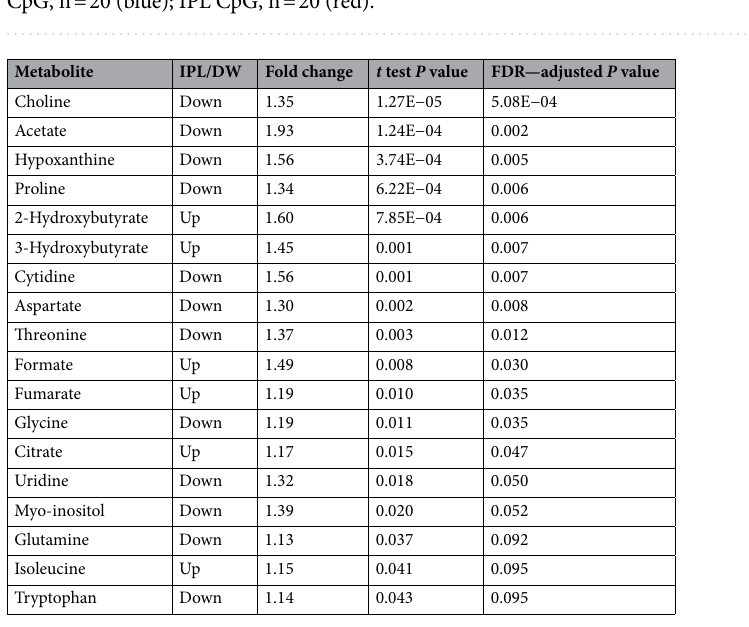
Figure 3. Partial Least Squares-Discriminant Analysis (PLS-DA) of serum metabolites in neonatal chicks 24 h post-treatment. PLS/DA scores plot classifying samples from IPL CpG-ODN treatment vs. DW controls ( a ), and IM CpG-ODN vs. DW controls ( b ), based on measurement of 40 metabolites. DW control, n = 18 (green); IM CpG, n = 20 (blue); IPL CpG, n = 20 (red).